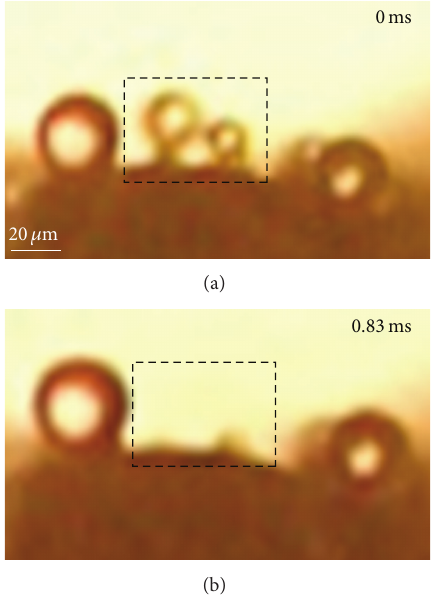
Figure 3: Self-propulsion of condensed secondary water droplets from the host drop. (a) Two particle-secondary droplet pairs in close proximity. (b) Less than 1 ms after the two secondary droplets have merged and self-propelled off the two surface bound particles. The particles remain on the surface of the host drop (see also Movie S5).